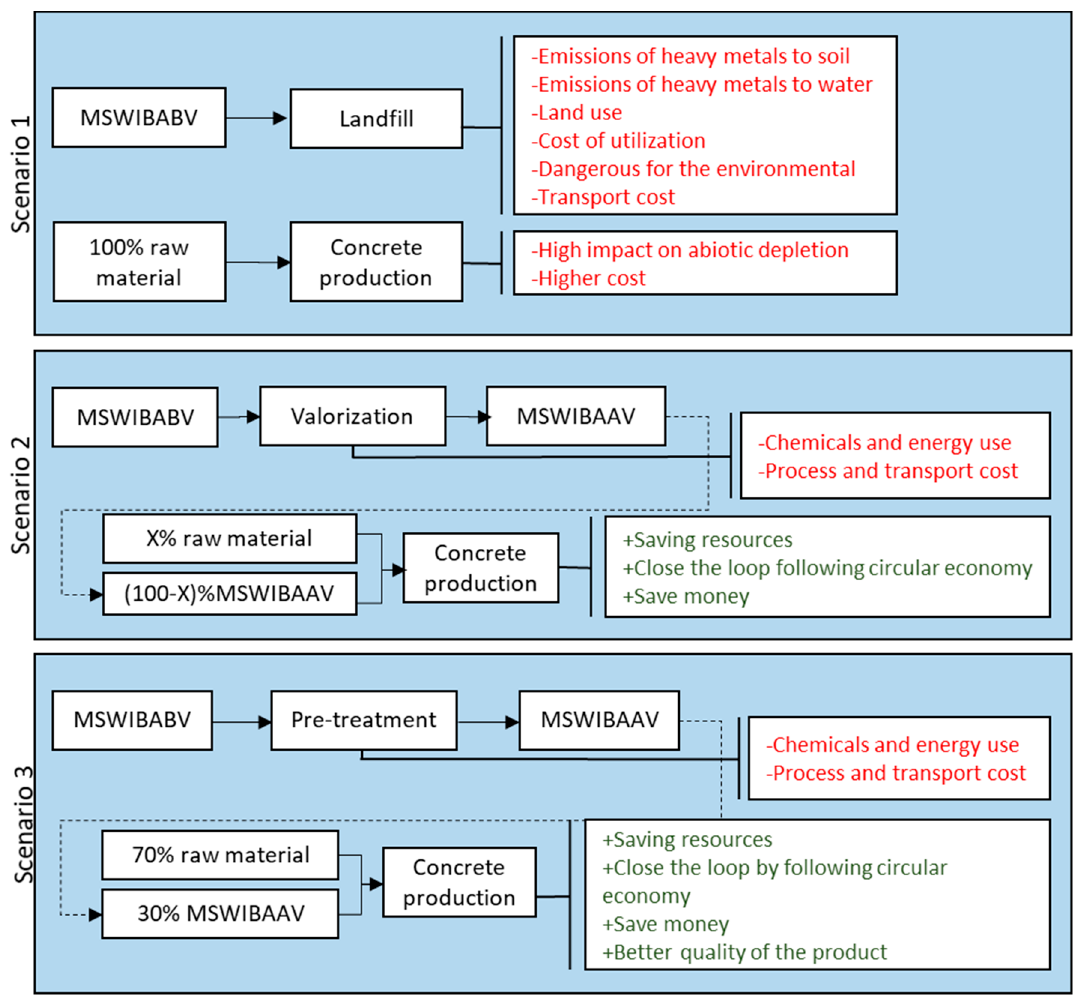
ff ects of di ff erent types of utilization Figure 7. Positive and negative effects of different types of utilization MSWIBA. Figure 7. Positive and negative e